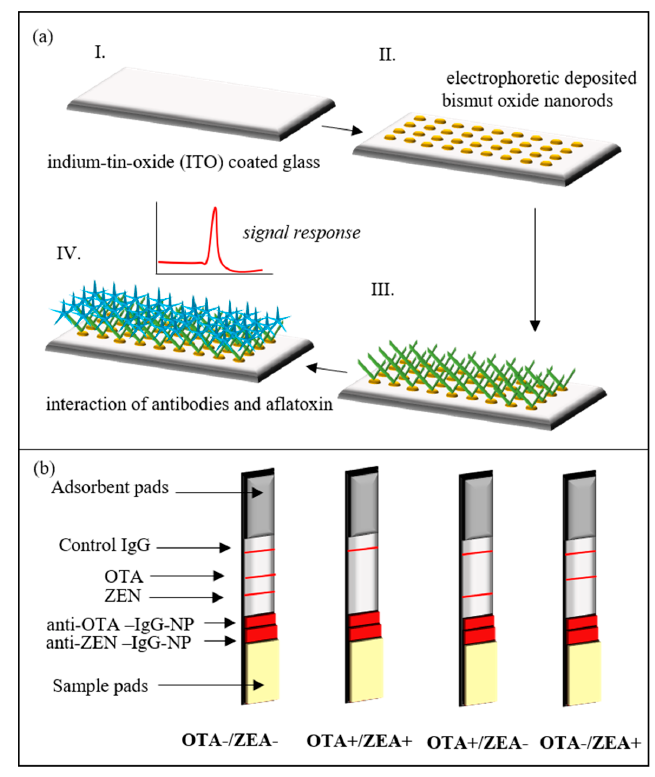
Figure 1. Different immunodetection arrangements. ( a ) An electrosensor based on the interaction of the antibody with mycotoxin, which amplifies the signal; ( b ) A lateral easy-to-use immunoassay for the detection of mycotoxins by the naked eye. Figures adapted from [37] and [42], with permission from Elsevier (2017) and John Wiley and Sons (2015), respectively.